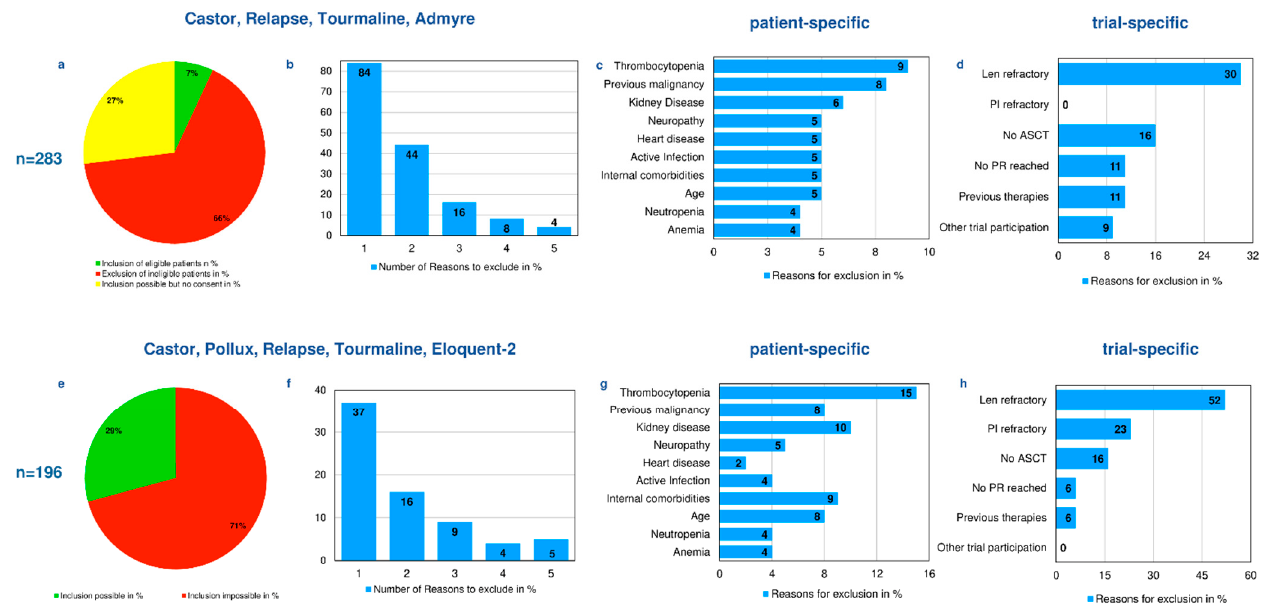
Figure 2. Second-line trials. ( a ) Patients included, excluded, and inclusion possible. ( b ) Number of reasons why patients had to be excluded. ( c ) Patient-specific reasons for exclusion. ( d ) Trial-specific reasons for exclusion. ( e ) Virtual view for if patients could have hypothetically been included in internationally recruiting trials. ( f ) Number of reasons for exclusion. ( g ) Patient-specific reasons for exclusion. ( h ) Trial-specific reasons for exclusion.